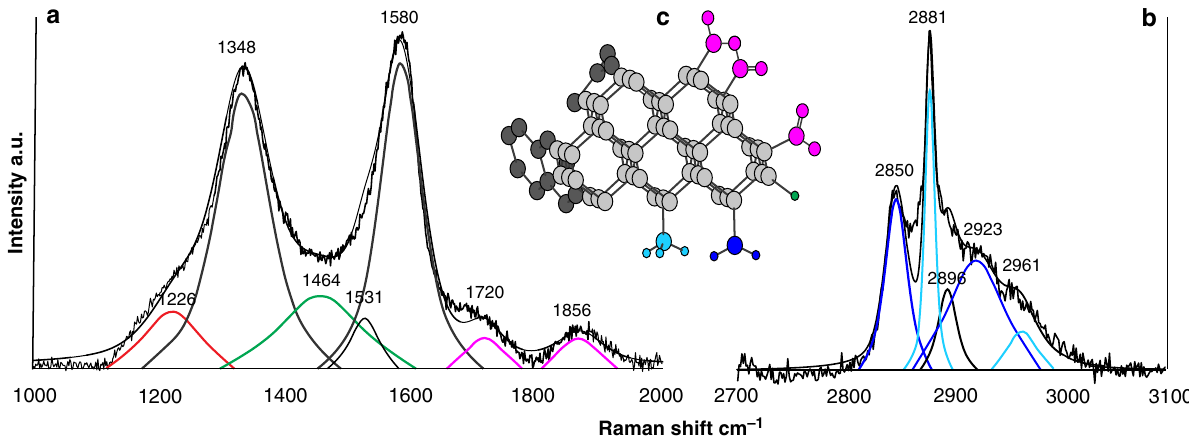
Fig. 3 Raman spectrum showing surface organic functional groups in diamonds. a The Raman spectrum is showing surface functional group vibrations in a nano-sized diamond (red band pro fi le at 1226 cm − 1 ) covered by a shell of sp 2 -bonded carbon. COO − groups are revealed by two broad bands centered at around 1720 and 1856 cm − 1 (pink band pro fi les). b The bands lying from 2800 to 3000 cm − 1 correspond to C-H vibrations in (CH 2 ) n and (CH 3 ) n groups (dark blue and light blue band pro fi les, respectively). The fi tted band at 2896 cm − 1 (black band pro fi le) corresponds to both (CH 2 ) n and (CH 3 ) n groups vibrations. c A schematic model showing the structure of nano-sized diamond surfaces revealed by Raman spectra. The crystalline diamond surface is covered by sp 2 -bonded carbon and organic functional potential 11,12 that prevail in the Lago di Cignana metamorphic units. Carbon saturation could have been catalyzed when hydrous fl uids started to equilibrate with the buffering slab-rock minerals